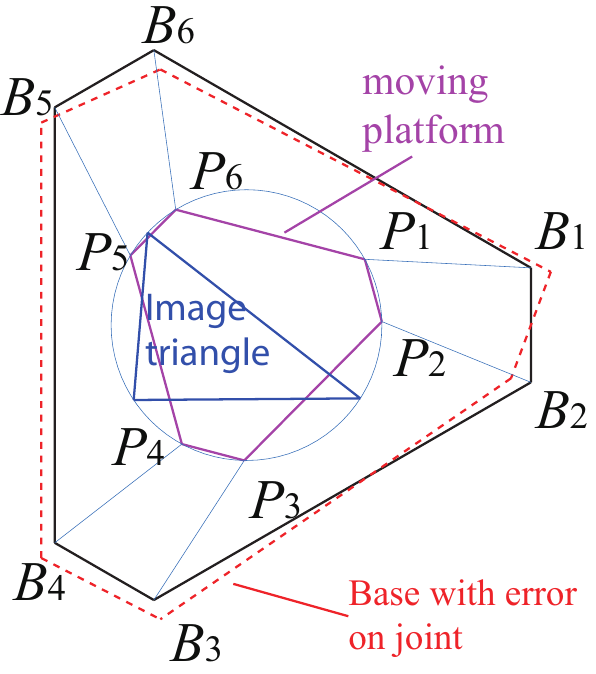
Figure 12. Gough–Stewart platform optimized using image moment visual servoing. Table 2. Design parameters and value of the objective function for the chosen controller.